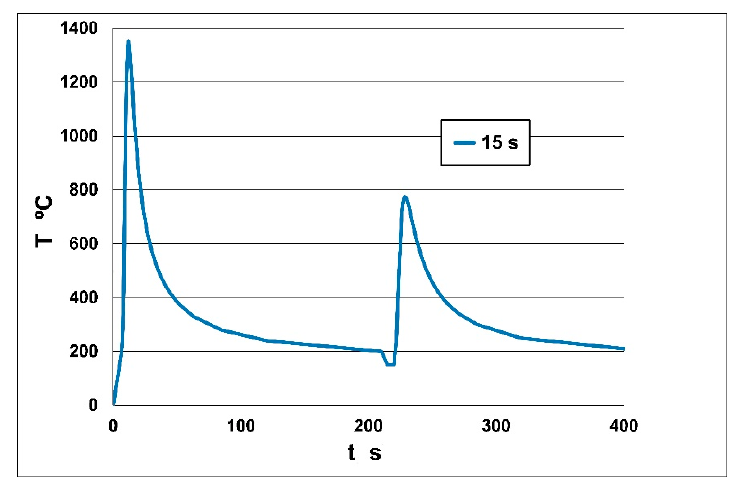
Figure 3. Intercritically reheated coarse-grained heat-affected zone (ICCGHAZ) thermal cycle ( t 8/5 = 15 s).